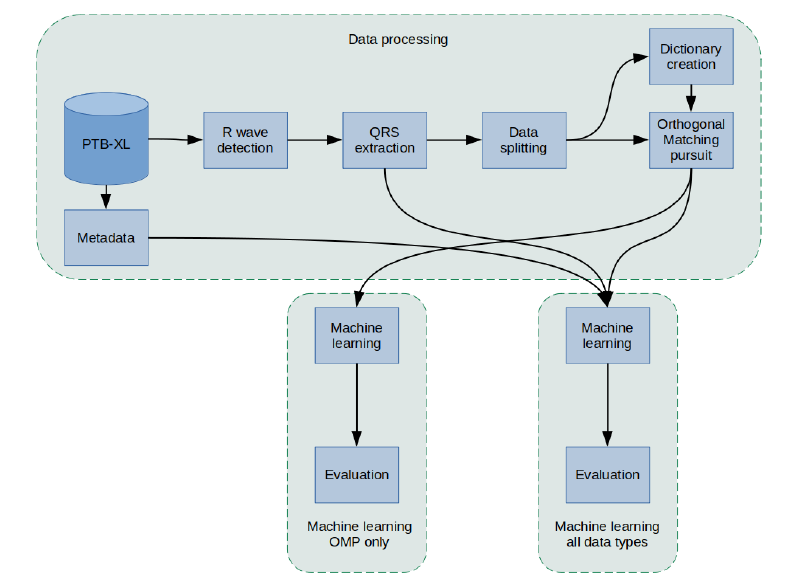
Figure 1. General overview diagram of the method.